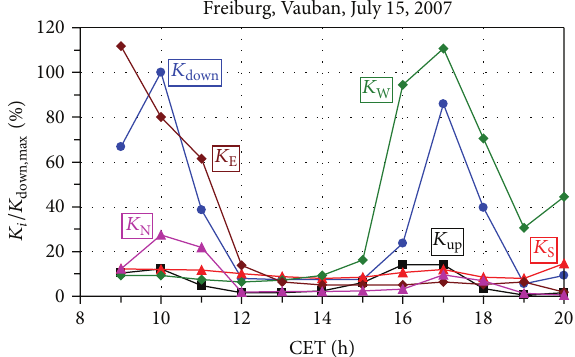
Figure 7: 1h mean values of the short-wave radiant flux densities 𝑖 = down, up, E, S, W, and N) reaching the human-biometeor- 𝐾 𝑖 ( ological reference person from the three-dimensional environment, related to the daily 1h peak value of 𝐾 NNE-facing sidewalk of a WNW-ESE street canyon, “Vauban” quarter in Freiburg during typical Central European summer